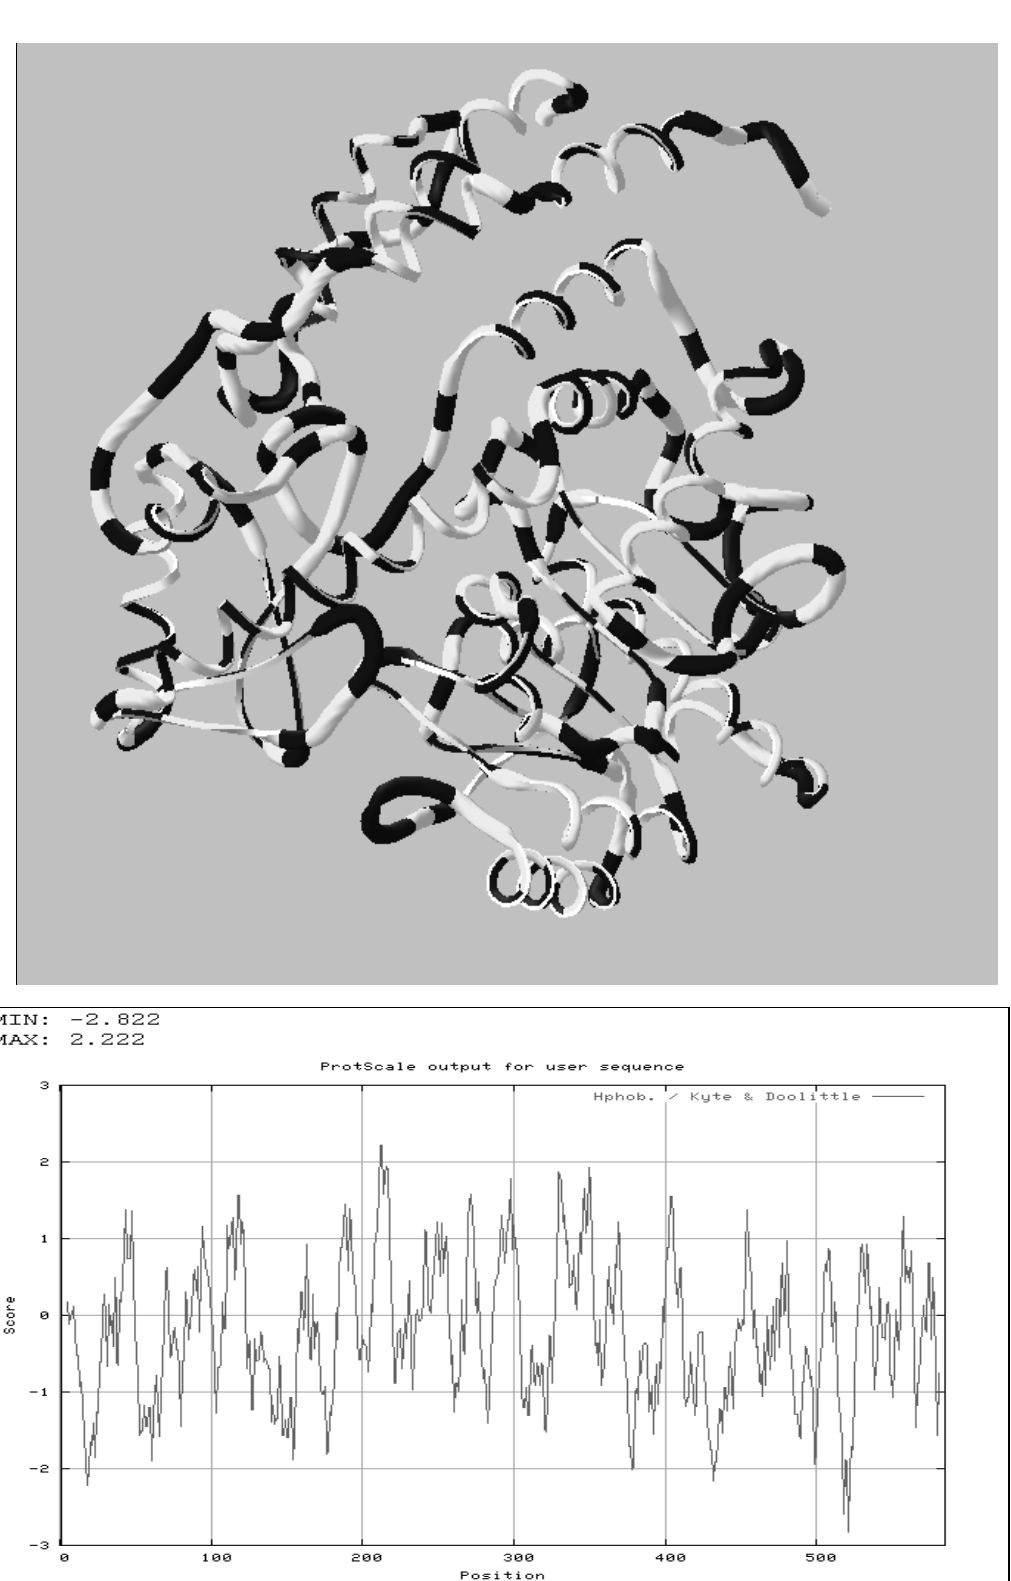
Figure 12: The figure shows the hydrophobicity plot of GAD 65 and the corresponding values mapped on the protein structure. Hydrophilic values are encoded in black and hydrophobic values are encoded in